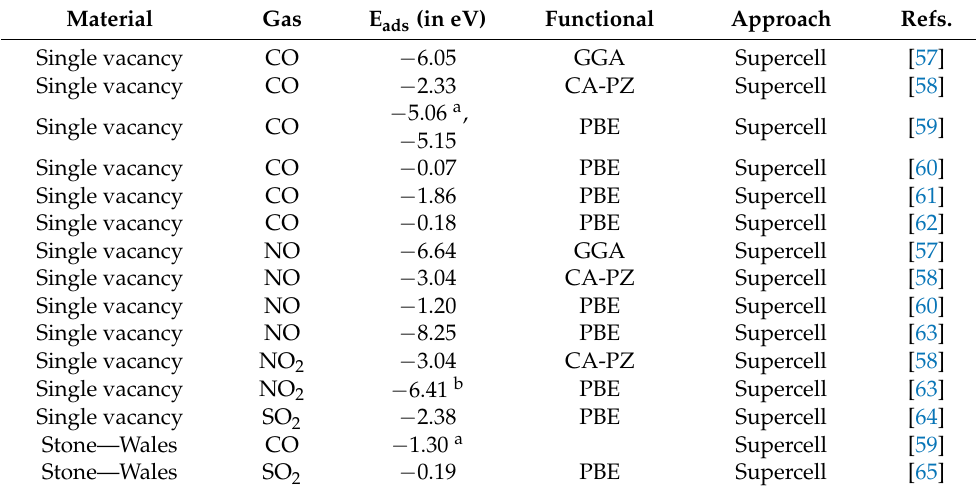
Figure 4. Optimized structures of armchair graphene nanoribbons (AGNRs) with gas molecules: ( a ) CO, ( b ) NO, and ( c ) NO 2 . It only shows the structure around the adsorbed molecule. Gray, white, red, and blue spheres represent C, H, O, and N atoms, respectively. Figure modified from [56]. Table 3. Adsorption energies of toxic gases on defective